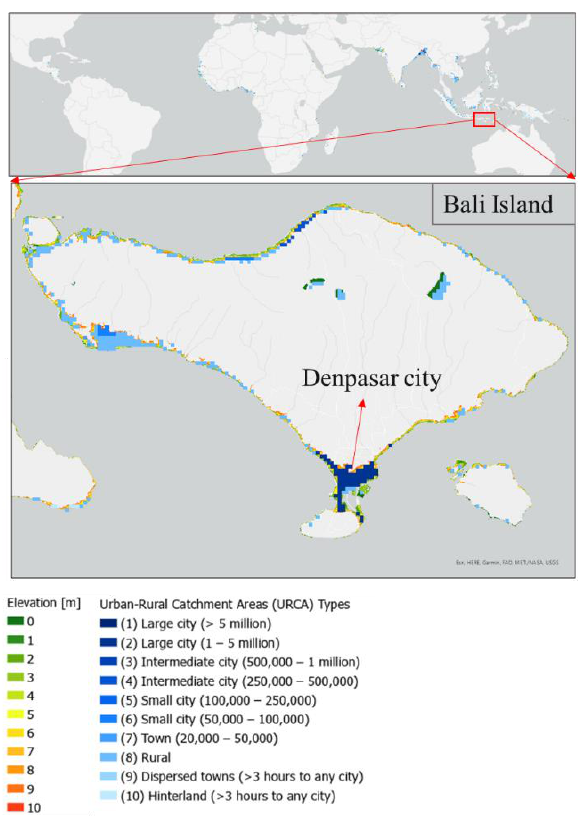
Figure 2. Distribution of Urban Settlement along LECZ across